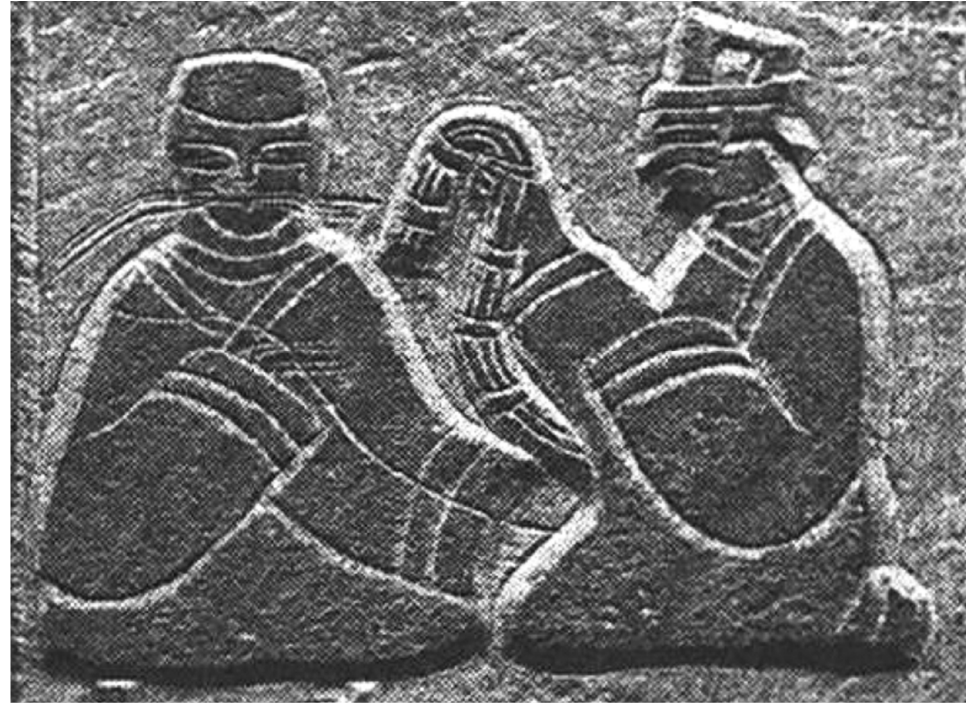
Figure 1. “Silkworm deity makes silk 蚕神吐丝 ” (Zhao 2019, pp. 110–23). Stone relief from the Han Dynasty. Unearthed in Yulin, Shanxi, China.